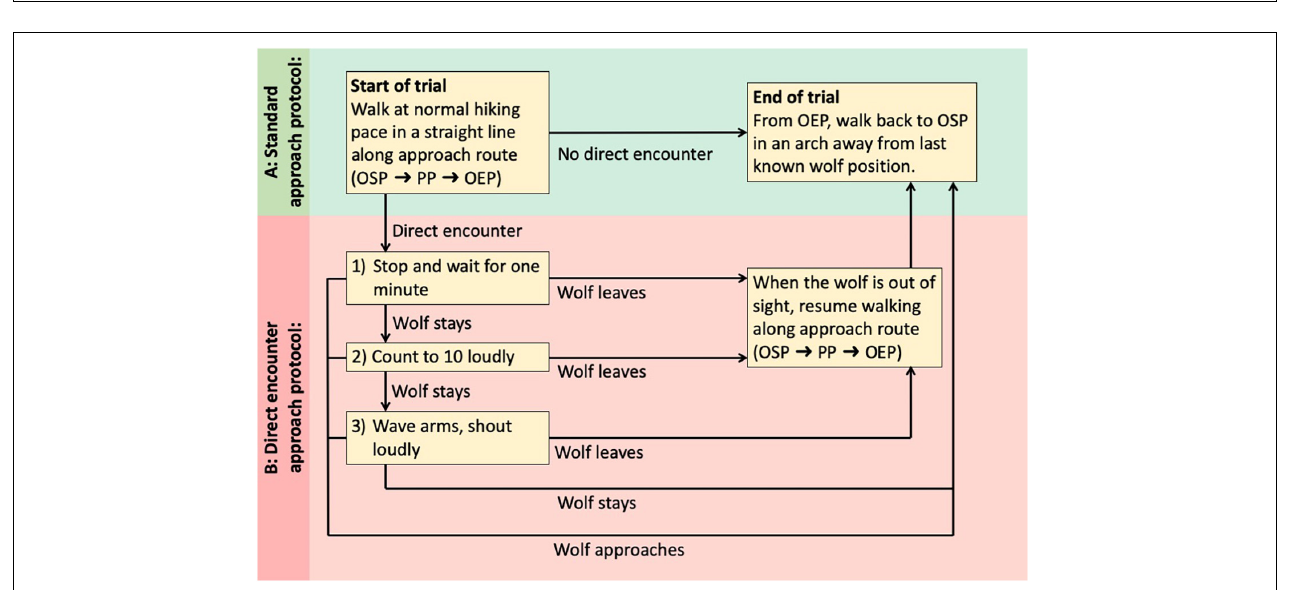
FIGURE 1 | Spatial arrangement of a standardized experimental human approach trial on wild wolves. OSP, observer start position; WSP, wolf start position; SD, starting distance; AR, approach route; PP, passing position; PD, passing distance; OEP, observer end position. Note that the graphic is not drawn to scale. Illustration: Juliana Spahr.